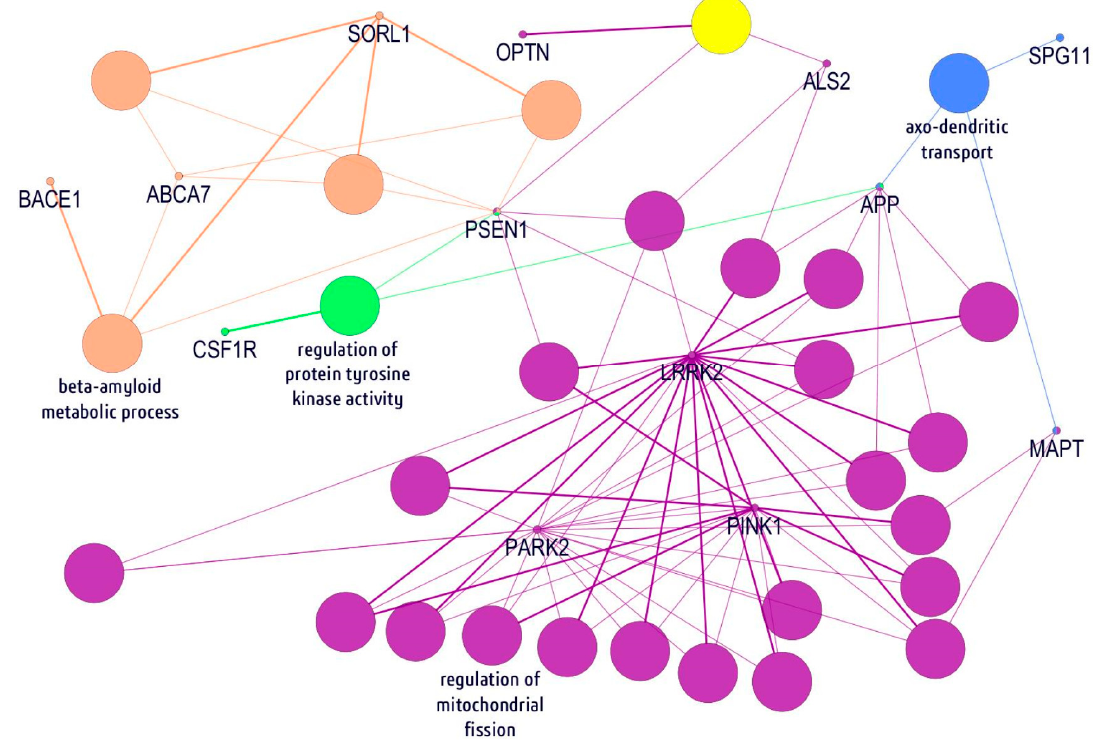
Figure 2. Visualization of neurodegenerative disorders of 23 genes in network modules. Each biological process was represented with the nodes which are connected with lines to indicate interactions. The orange nodes indicated beta-amyloid metabolic process genes, while regulation of protein tyrosine kinase activity and mitochondrial fission genes are presented as green/yellow and purple, respectively. The light-blue nodes revealed genes associated with axo-dendritic